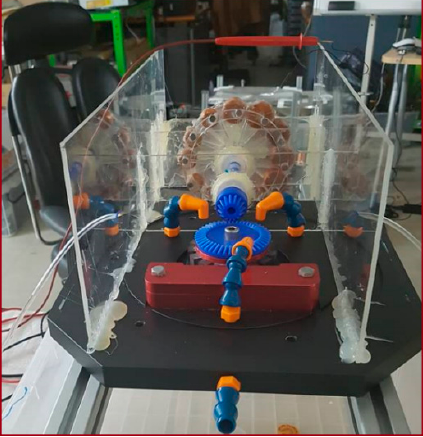
Figure 6. Fabricated model of the integrated thermomagnetic engine with the hybrid